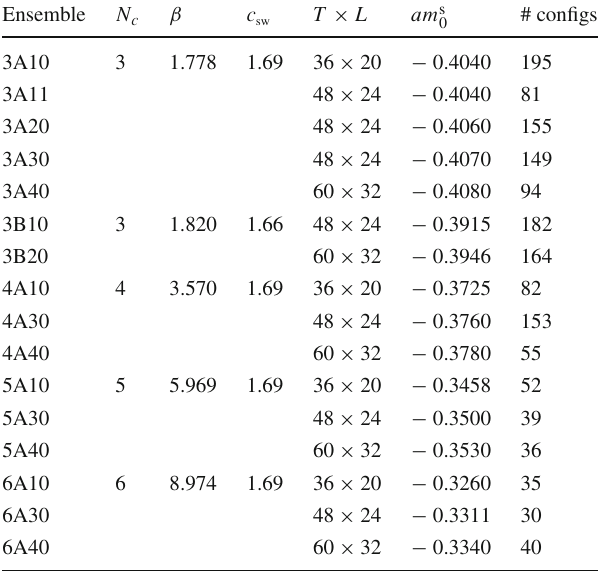
Table 3 Summary of the simulation parameters of the various ensem- bles used in this work